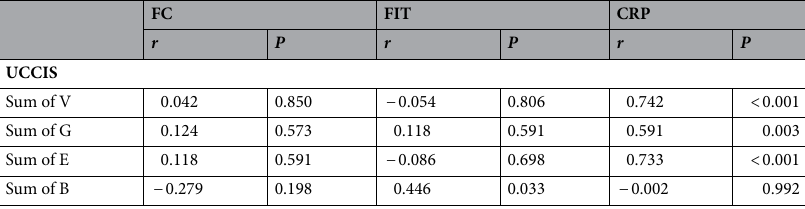
Table 6. Correlations between biomarkers and the descriptors of UCCIS in the MES 2, 3 group. UCCIS Ulcerative colitis colonoscopic index of severity, FC Fecal calprotectin, FIT Fecal immunochemical occult blood test, CRP C-reactive protein, r Correlation coefficient, V Vascular pattern, G Granularity, E Erosions and ulcers, B Bleeding, Sum of V Sum of vascular pattern, Sum of G Sum of granularity, Sum of E Sum of erosions and ulcers, Sum of B Sum of